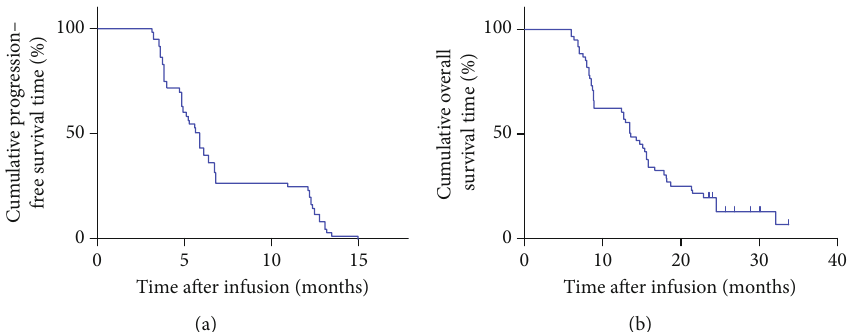
Figure 2: Kaplan-Meier curves for PFS and OS of patients, N = 60 . (a) The PFS curve of patients. (b) The OS curve of patients.